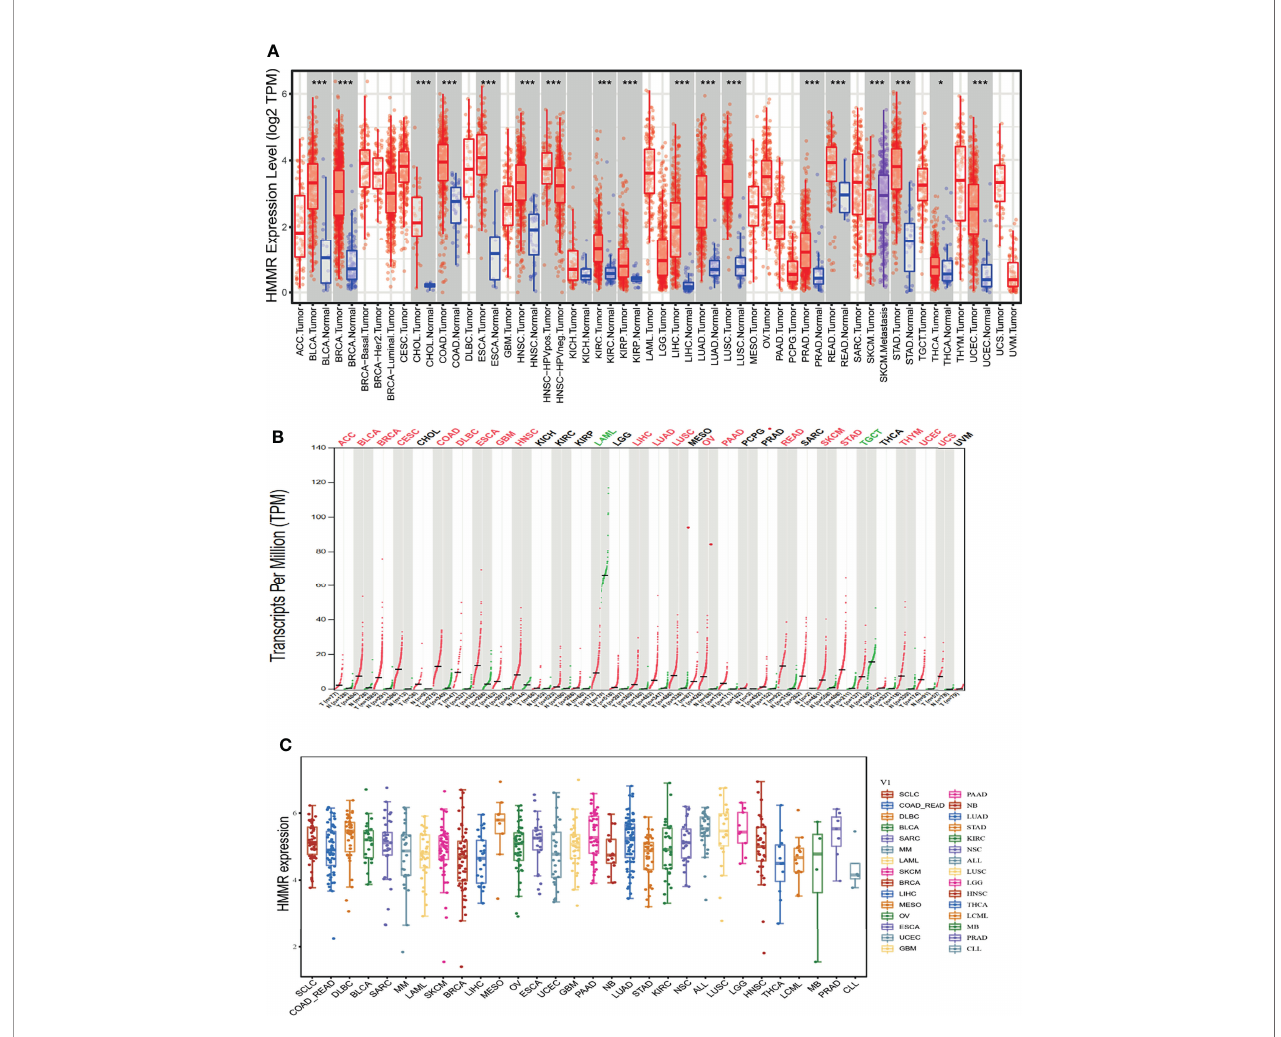
FIGURE 1 | HMMR was highly expressed in pan-cancer. (A) The expression of HMMR in pan-cancers examined by TIMER tools. (B) The expression of HMMR in pan-cancers examined by GEPIA tools. (C) The expression of HMMR in pan-cancers cells lines examined by CCLE database. *P < 0.05; ***P <